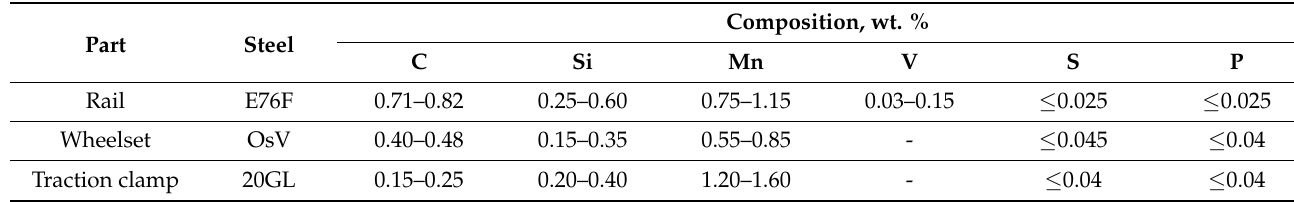
Table 2. Chemical composition of the test samples’